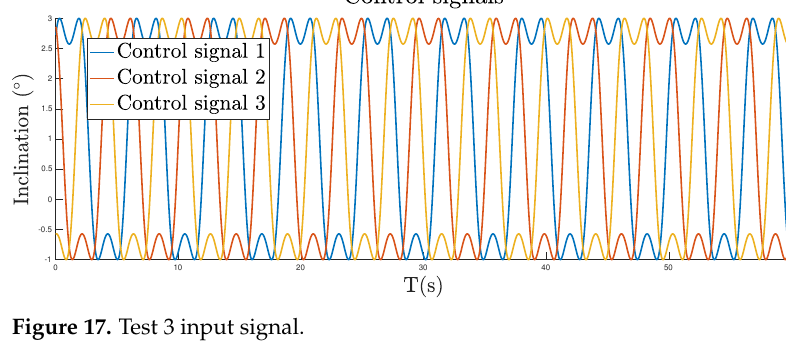
Figure 17. Test 3 input signal.